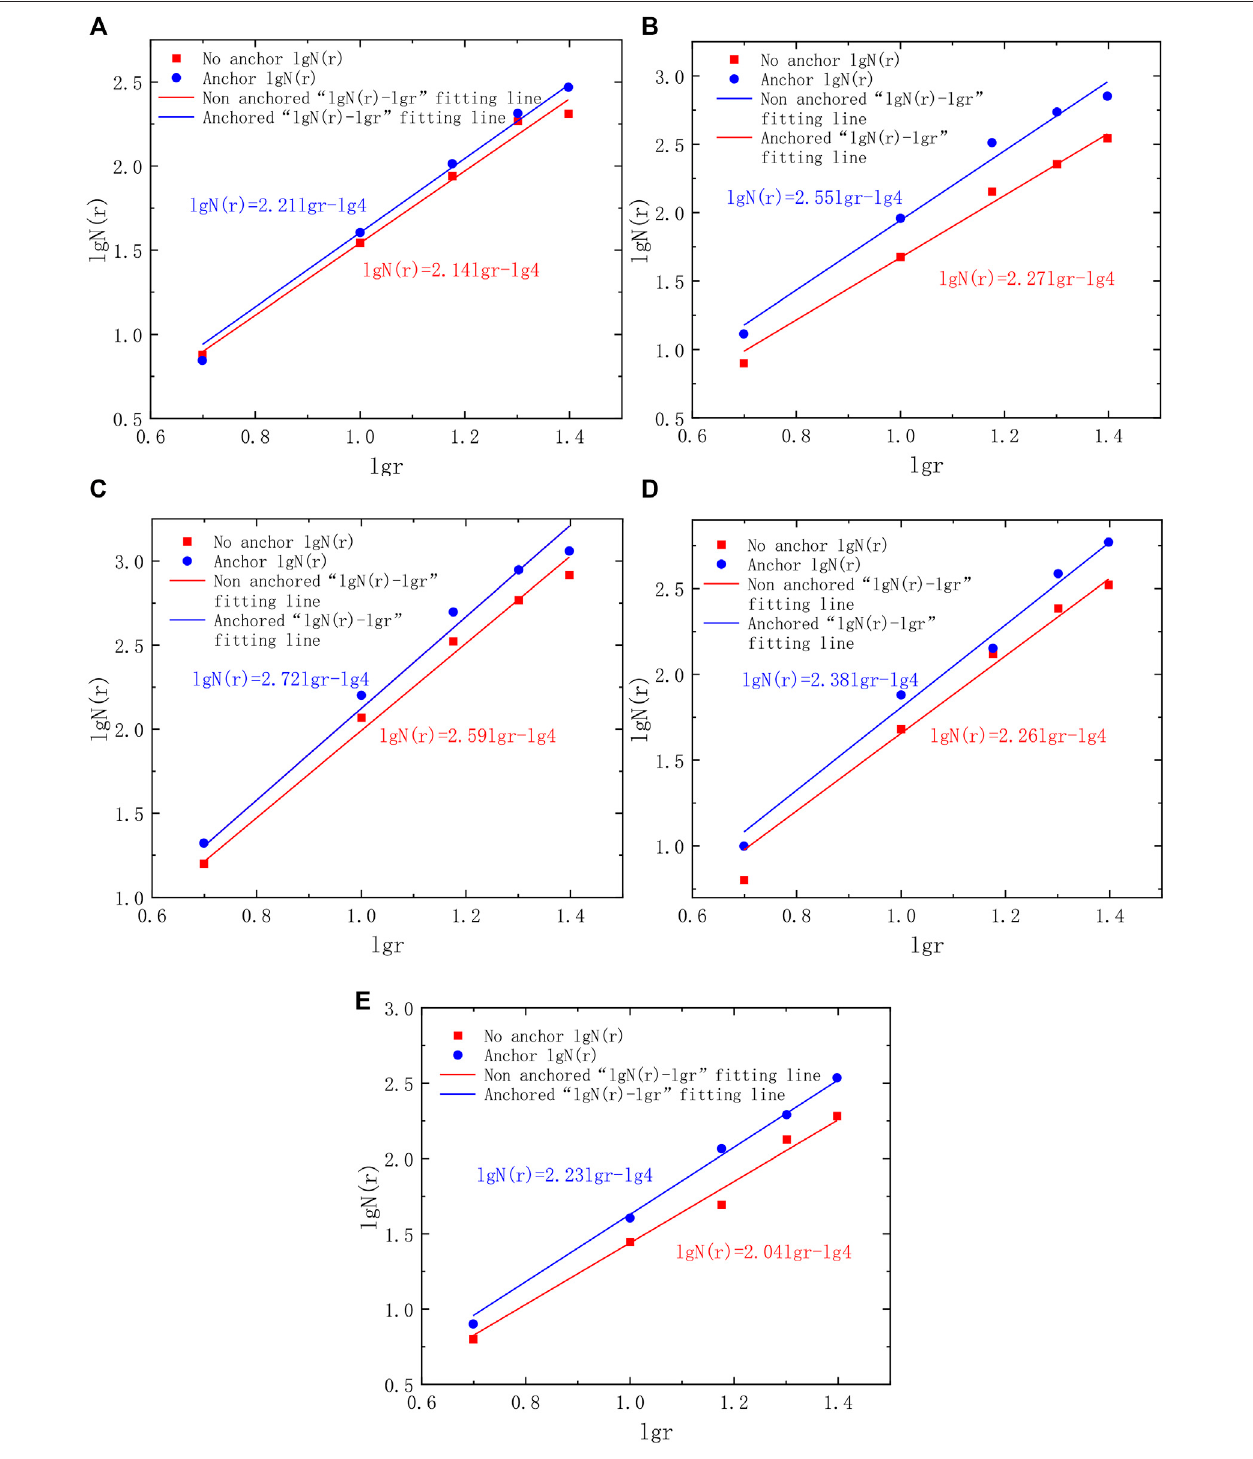
FIGURE 12 | Fractal dimension fi tting line of layered sandstone: (A) 0 ° sandstone; (B) 30 ° sandstone; (C) 45 ° sandstone; (D) 60 ° sandstone; (E) 90 ° sandstone.